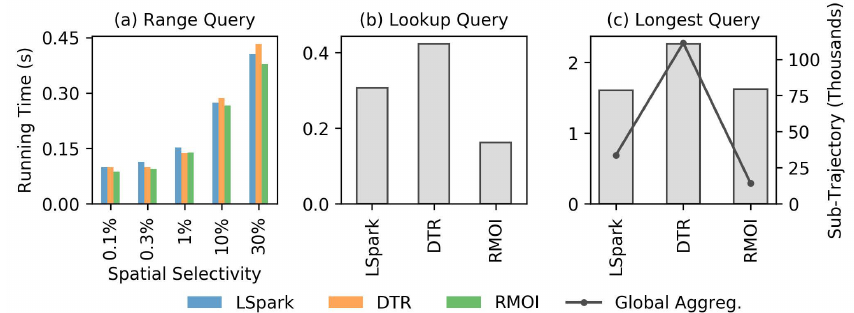
Figure 7. Average execution time for the UK + IE dataset with high resource availability on ( a ) range query, ( b ) lookup query, and ( c ) longest query.